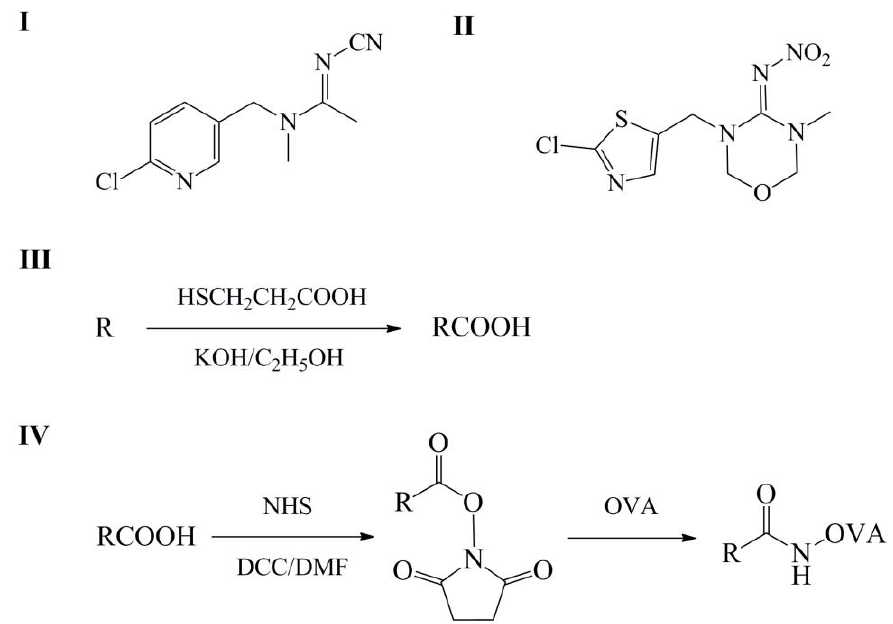
Figure 3. I: the chemical structure of acetamiprid; II: the chemical structure of thiamethoxam; III: the synthetic route to the acetamiprid hapten; IV: the active ester method.